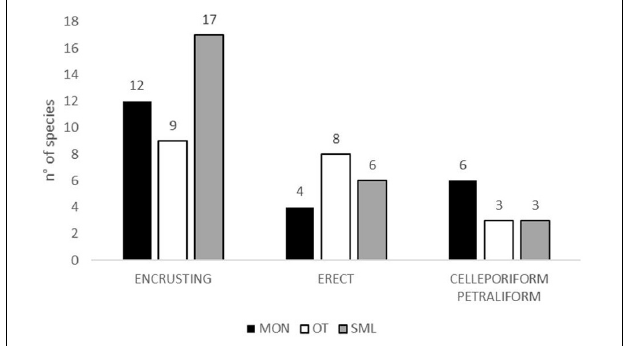
FIGURE 3 | Number of species for zoarial types for each site; Monopoli = black; Otranto = white; Santa Maria di Leuca =